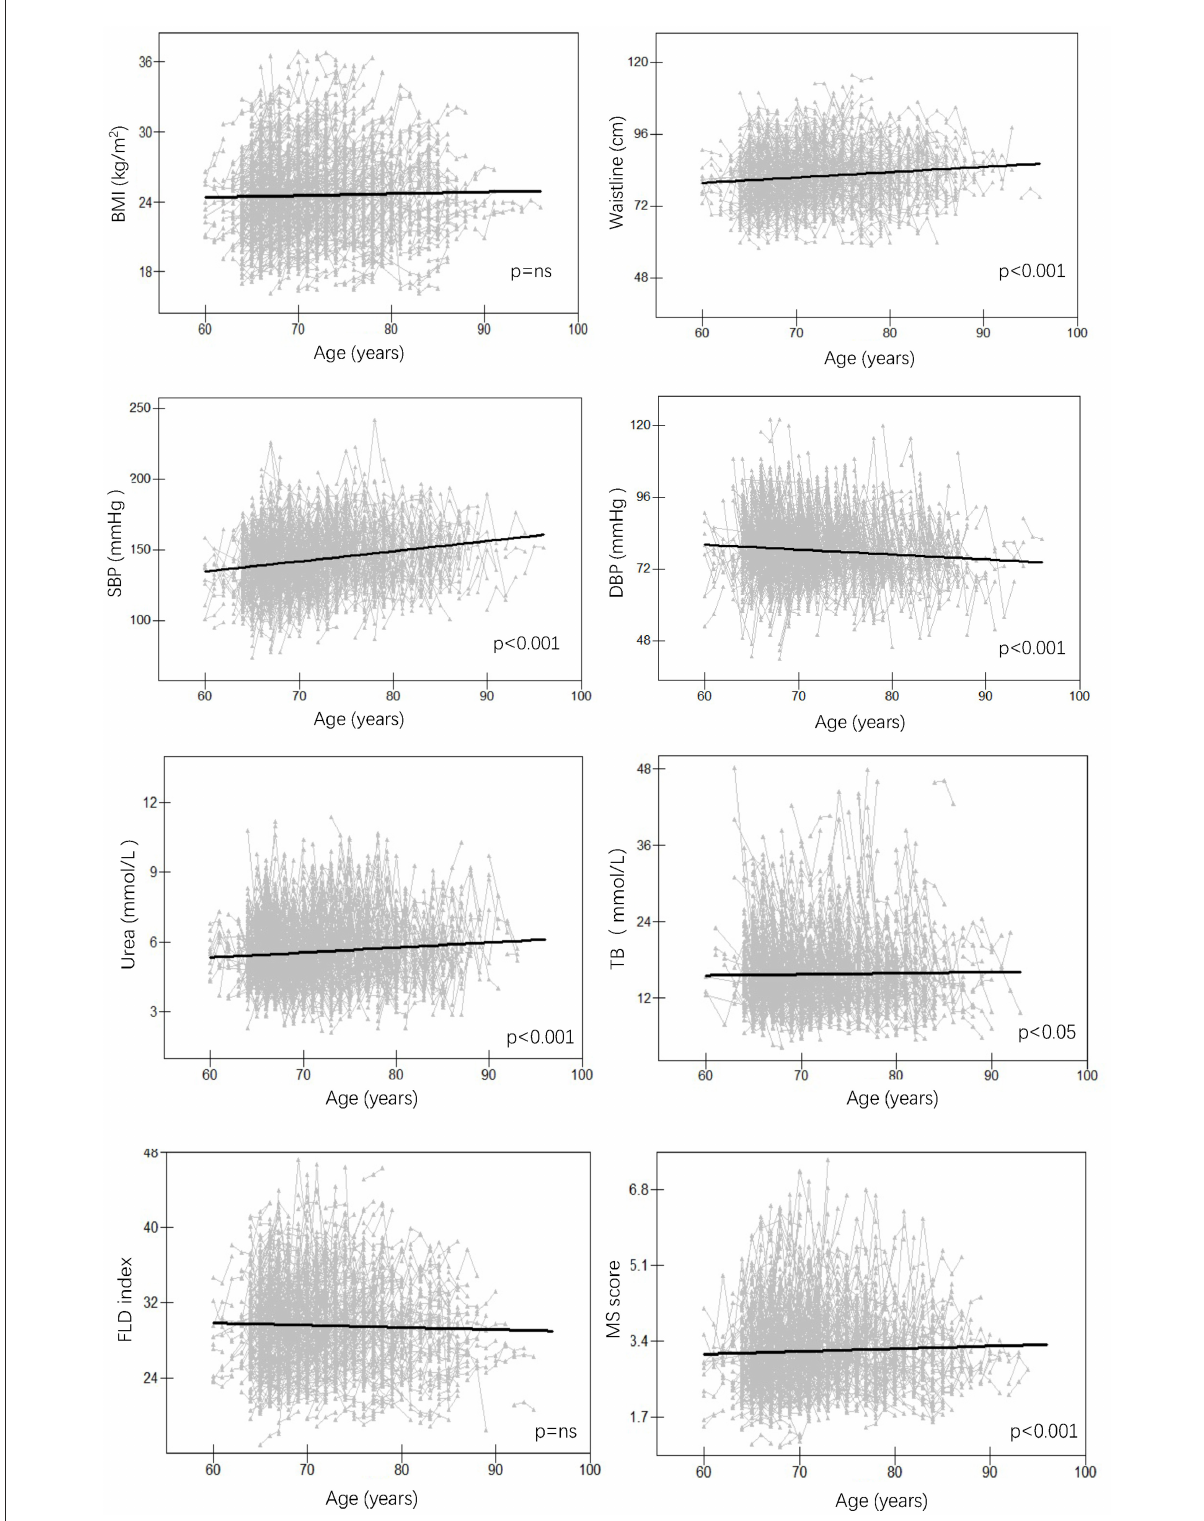
FIGURE2 Longitudinal change pattern in females. BMI, body mass index; DBP, diastolic blood pressure; FLD index, fatty liver disease index; MS score, metabolic syndrome score; SBP, systolic blood pressure; TB, total